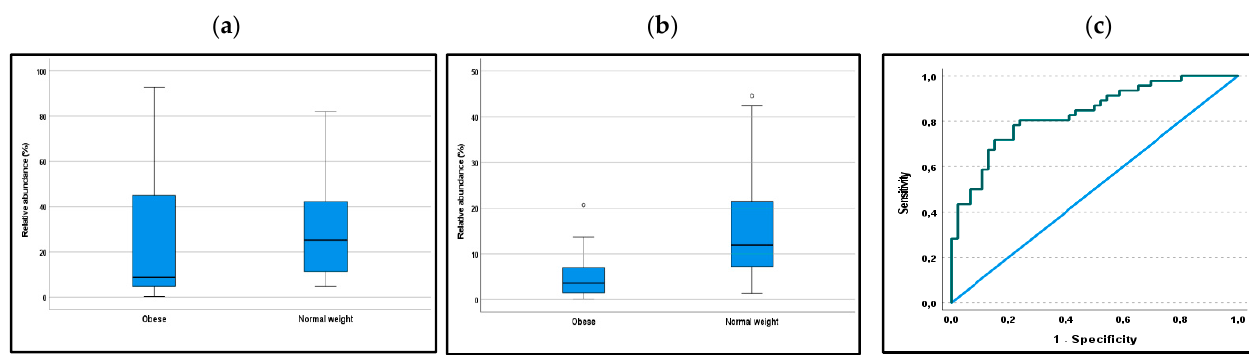
Figure 1. ( a ): The relative abundance (%) of 17 bacteria with significant differences between subjects with morbid obesity and normal weight. ( b ) shows the corresponding results of a post hoc analysis of 8 bacteria that showed the best separation between the groups. The figures show the interquartile ranges, and the circles show two outliers. The differences between the groups were statistically significant ( p = 0.001 and p < 0.001, respectively; Mann–Whitney U-test). ( c ): The receiver operating characteristic (ROC) curve shows the eight selected bacteria’s diagnostic properties for the diagnosis of obesity. The AUC is 0.83 (95% CI: 0.75–0.92; p < 0.001).